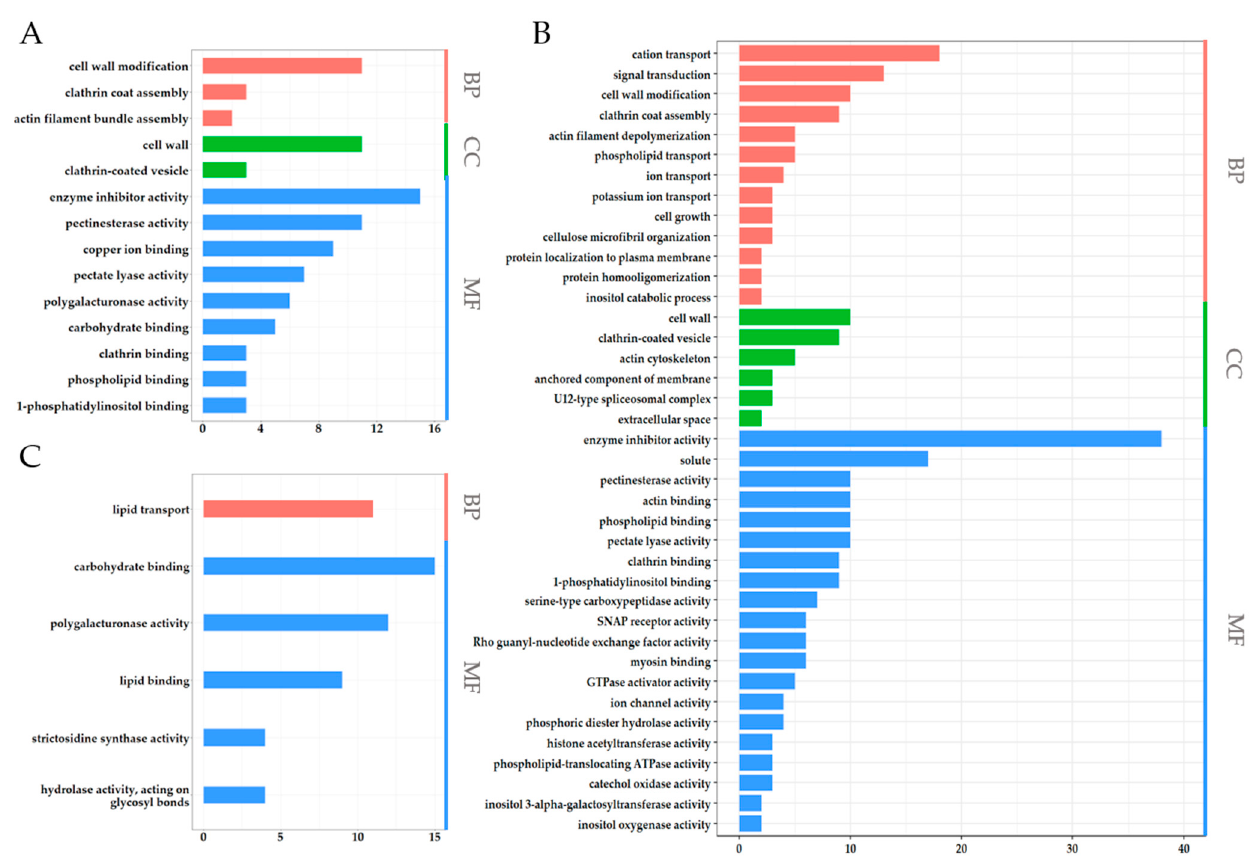
Figure 6. Gene ontology (GO) enrichment analysis of APSGs, PSGs, and ASGs in H05. ( A ) GO term enrichment analysis of APSGs; ( B ) GO term enrichment analysis of PSGs; (C) GO term enrichment analysis of ASGs; In ( A – C ), the x-axis represents the gene number assigned to a GO term, and the y-axis is the list of significantly enriched GO terms. These significantly enriched GO terms were selected based on a p -value < 0.05 and a q -value < 0.2. GO terms of the categories of biological processes, cellular components, and molecular functions are shown in red, green, and blue, respectively.